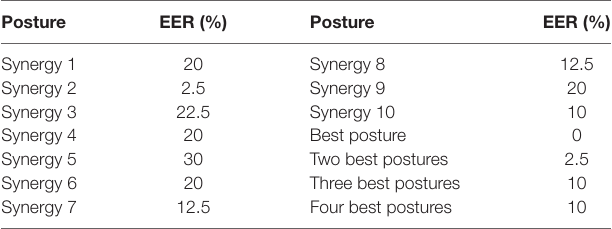
TaBle 2 | equal error rate (eer) for each postural synergy. Posture